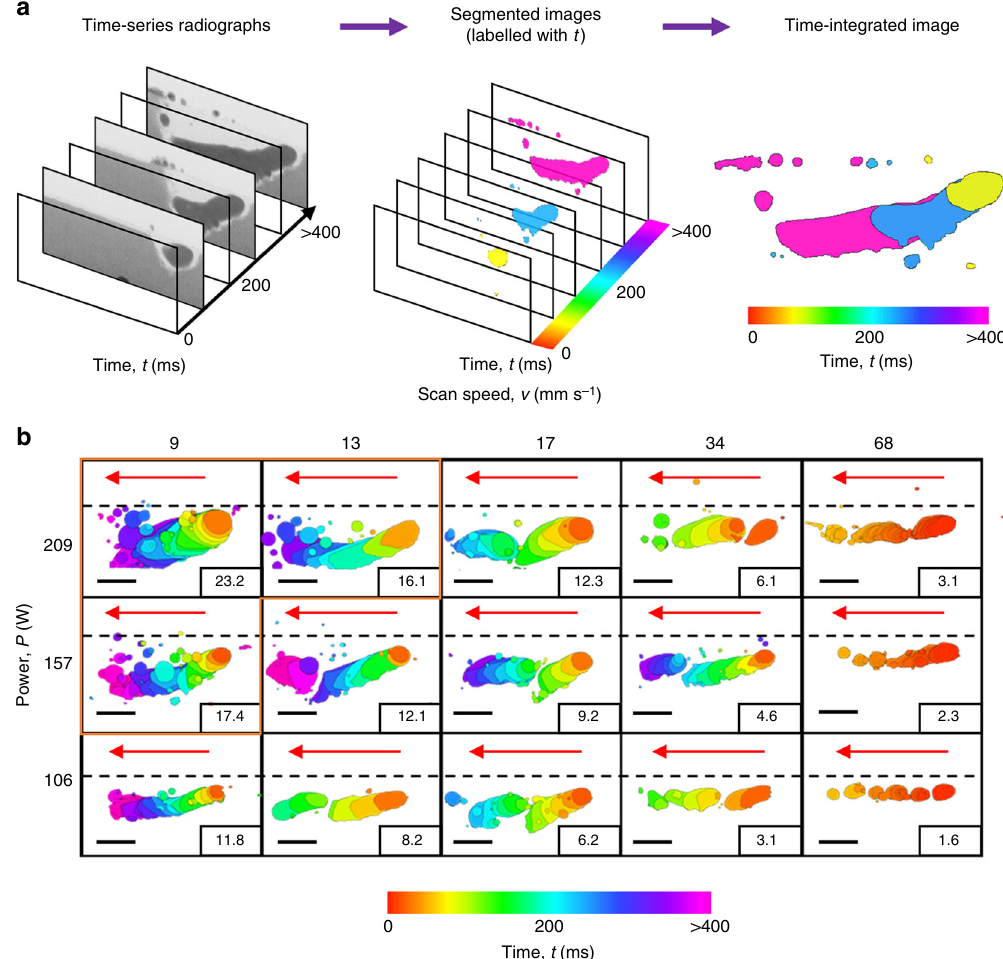
Fig. 2 Time-resolved melt track morphologies under different process parameters. a Steps to produce a time-integrated image. Each time-series of radiographs is segmented and labelled with time, and then fl attened into a time-integrated image. b A mechanism map combining 15 time-integrated images illustrates the dynamic changes of molten pool behaviour and melt track morphologies with respect to P , v , and LED (indicated by the numeric value at the corner of each time-integrated image). The black dotted line indicates the powder bed surface. Red arrows indicate the scan direction of the laser beam. Scale bars = 2